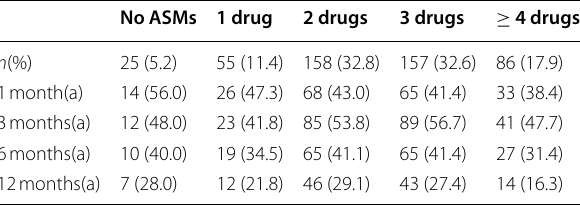
Note: ASMs anti-seizure medications; a: The response rate in the population with maintenance or reduced ASMs and more than 50% seizure reduction. Data are provided as n (%)